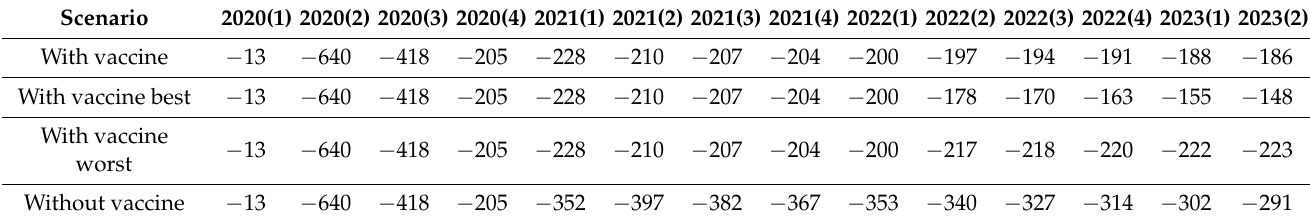
Table A6. Reduction in national headcount employment (000s) with and without vaccine vs. no COVID scenario.